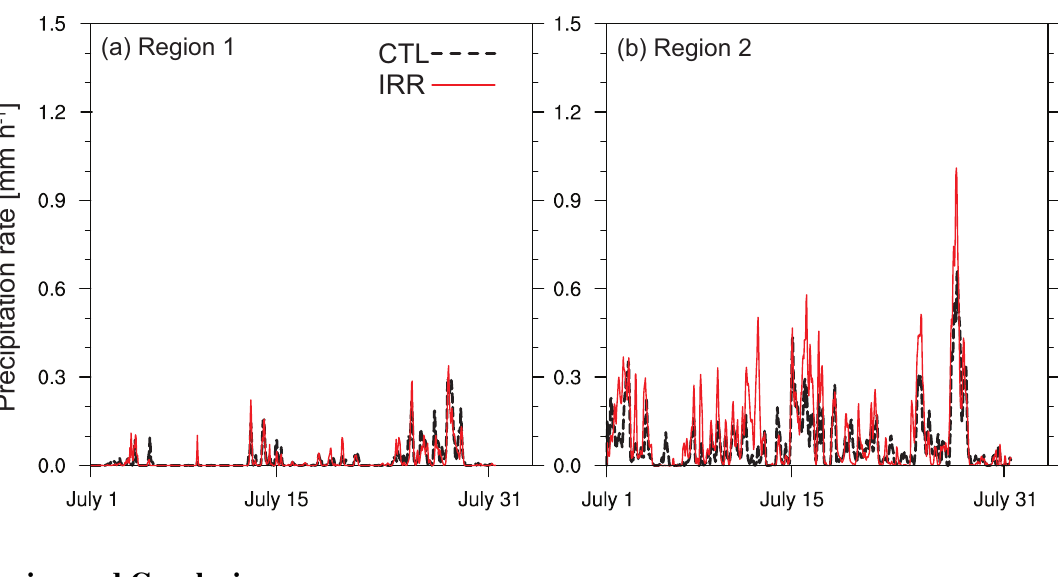
Figure 12. Spatially-averaged precipitation time-series for ( a ) region 1 and ( b ) region 2 for the CTL and IRR simulations. The mean precipitation for each region listed in Table 2 corresponds to the accumulated precipitation from these time